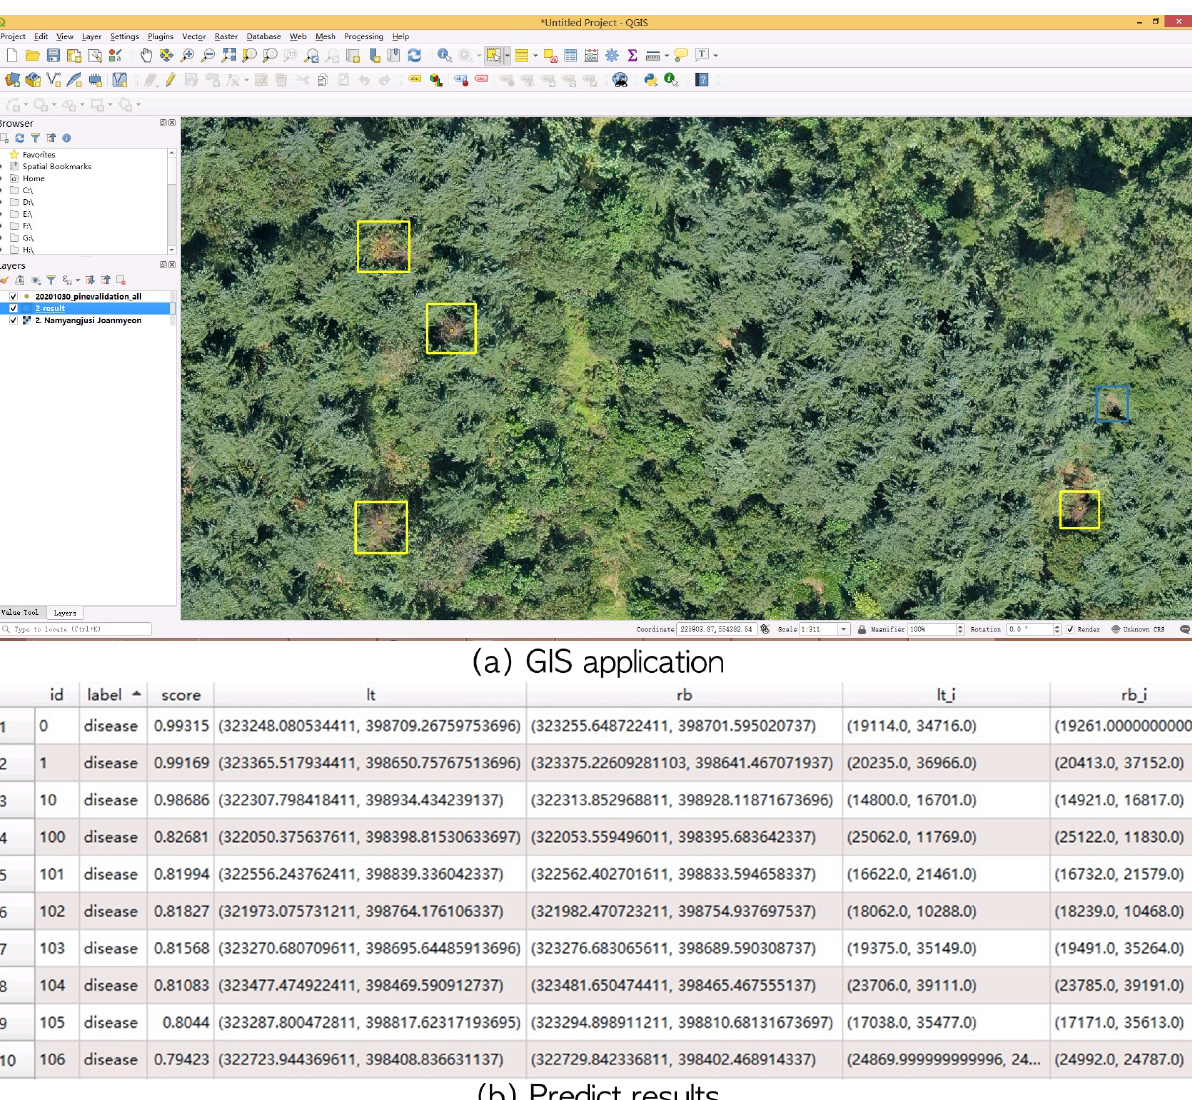
Figure 9. Visualization of the inference result in the QGIS